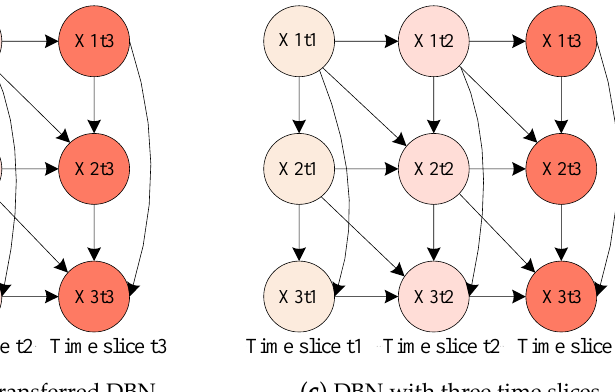
Table 1. Sources of the 207 global collision accident investigation reports.